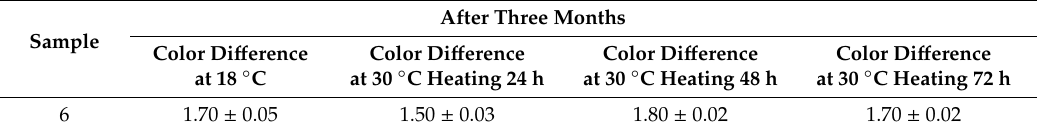
Table 12. E ff ect of time on the color di ff erence of discoloration